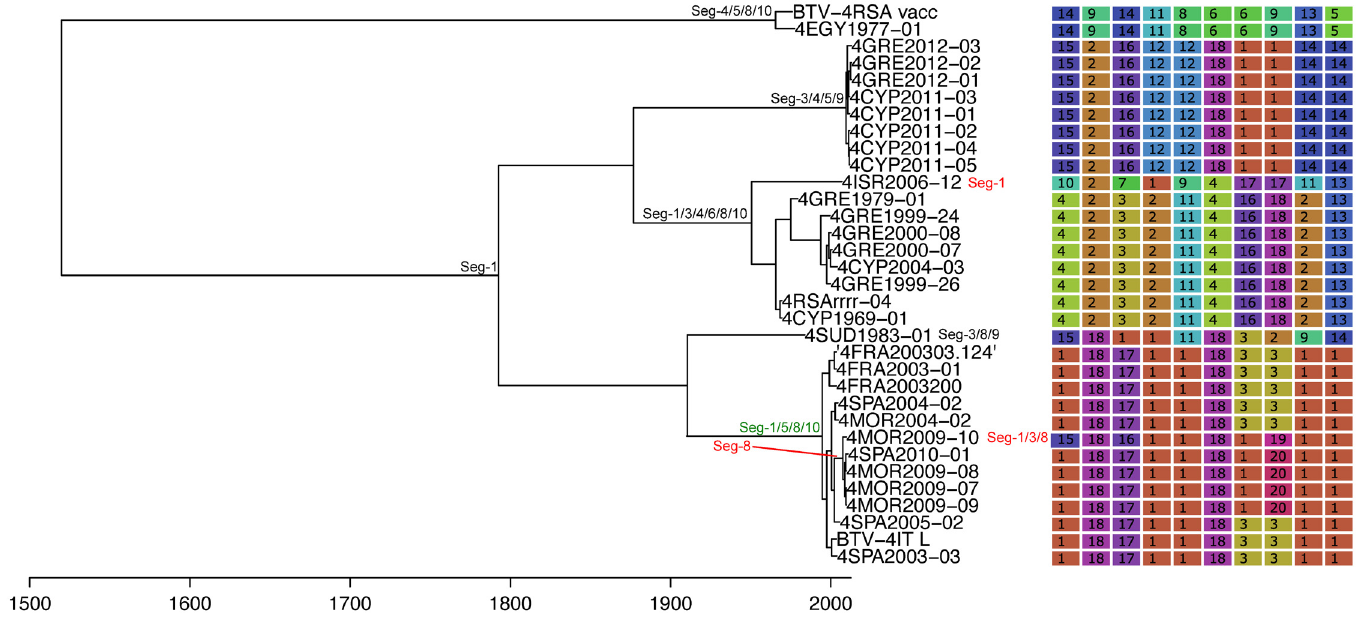
Fig 6. Time-scaled Seg-2 phylogeny of European BTV-4 isolates. See Fig 4 for